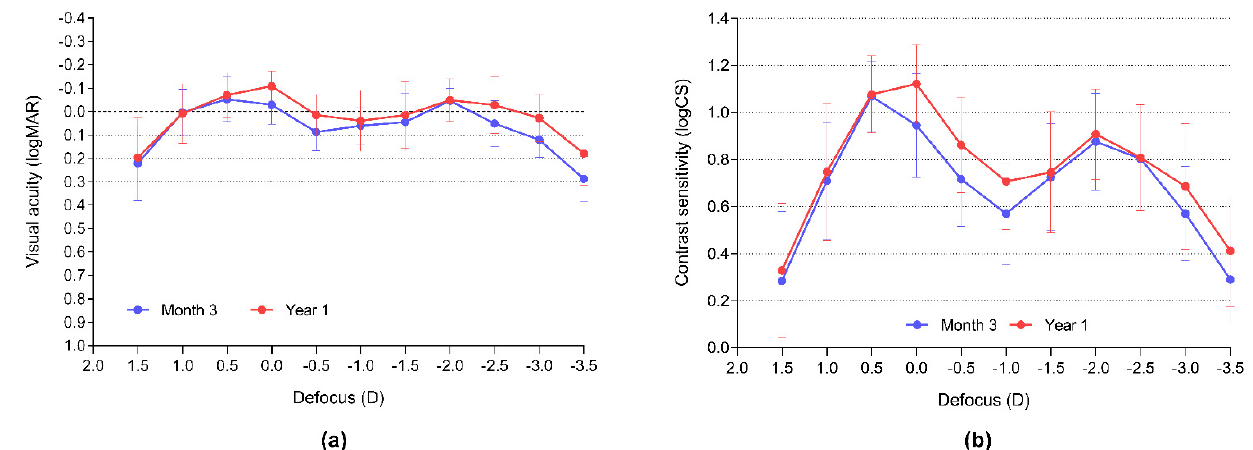
Figure 5. Binocular visual acuity ( a ) and contrast sensitivity ( b ) defocus curves confirm stable visual outcomes.